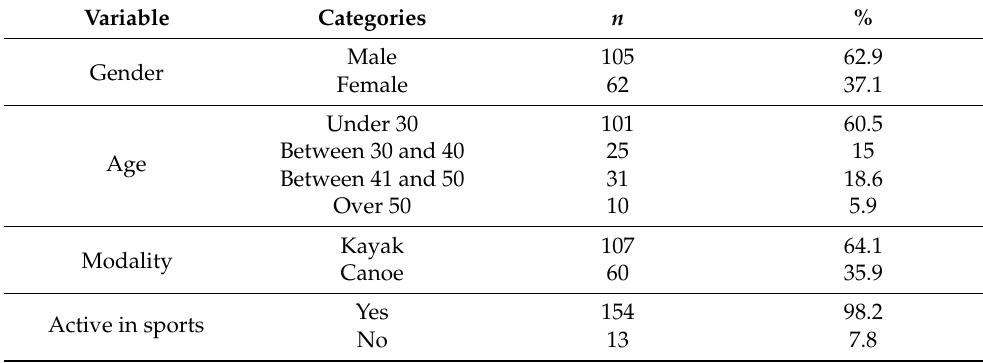
Table 3. Characteristics of the sample ( n = 167).